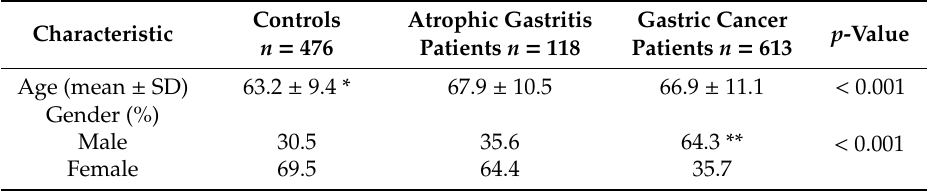
Table 2. Characteristics of the study